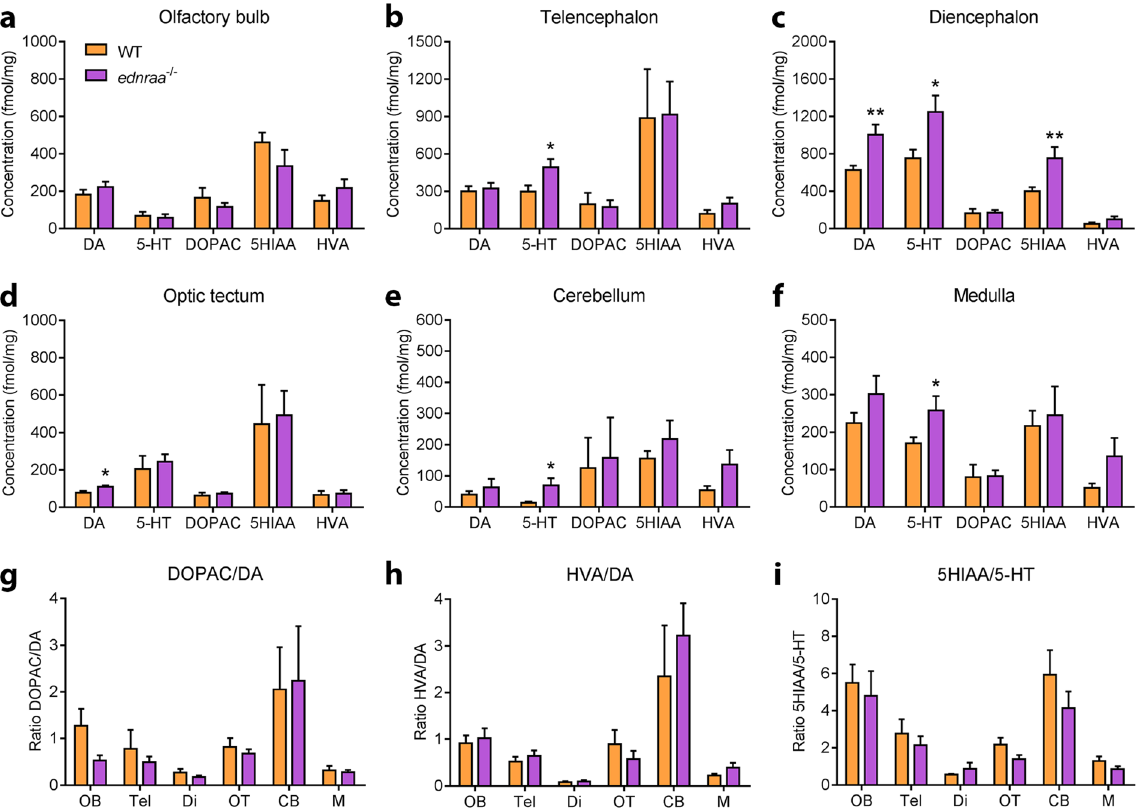
Figure 8. Increased basal levels of 5-HT and dopamine in ednraa − / − . ( a) There are no differences in the olfactory bulb. 5-HT levels are increased in the (b) telencephalon, (c) diencephalon, (d) cerebellum and (f) medulla of ednraa − / − compared to WT. Dopamine levels are significantly higher in the (c) diencephalon and (e) optic tectum of ednraa − / − compared to WT. (c) 5HIAA is increased in the diencephalon of ednraa − / − . (g–i) There are no differences in the utilisation ratio of dopamine and 5-HT in ednraa − / − compared to WT. n = 9 each genotype. * p < 0.05, ** p < 0.01. OB: olfactory bulb, Tel: telencephalon, Di: diencephalon, OT: optic tectum, CB: cerebellum, M: